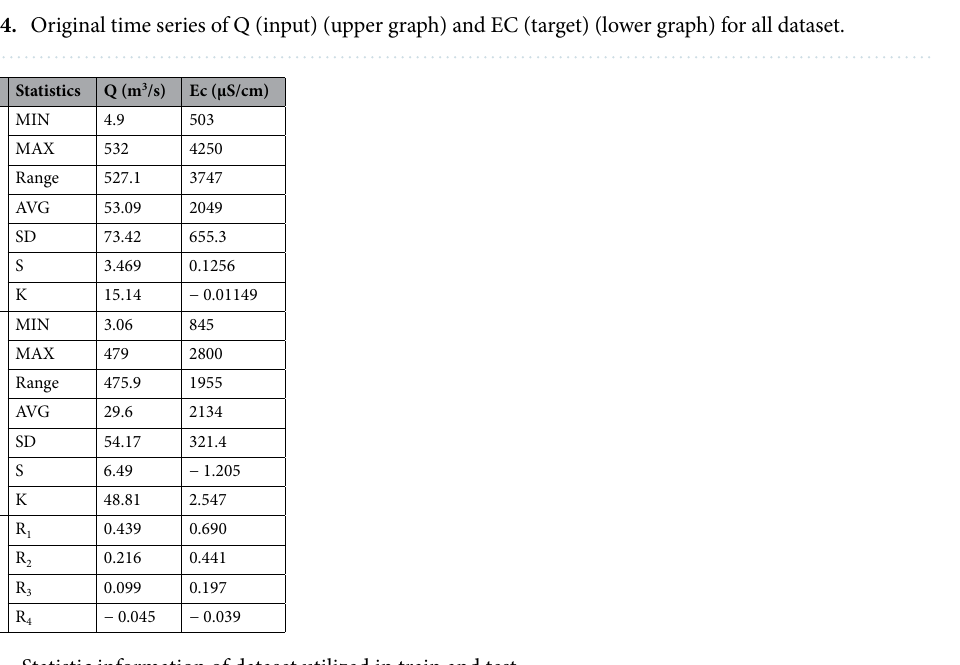
Table 1. Statistic information of dataset utilized in train and